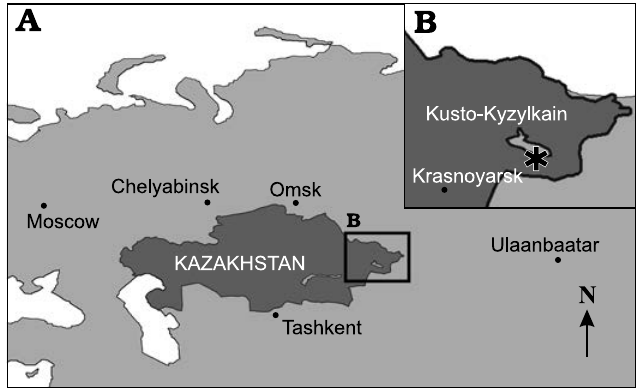
Fig. 1. General outline map showing the geographical position of Kazakh- stan ( A ) and Kusto-Kyzylkain locality (asterisk) at Zaysan Basin ( B